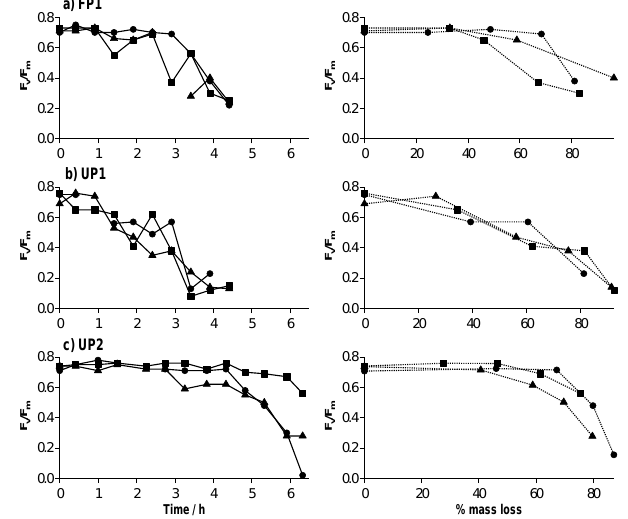
Figure 3. F v /F m changes relative to time (left column) and % mass loss (right column) during desiccation of (a) F. vesiculosus and (b, c) U. intestinalis . Sample mass was not measured at every time point, see Sect. 3.2 for further details. Symbols represent the three biological replicates used in each experiment, see Table 1 for further